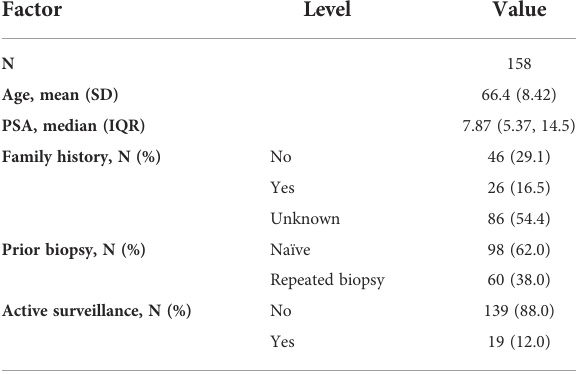
TABLE 1 Baseline characteristics of the